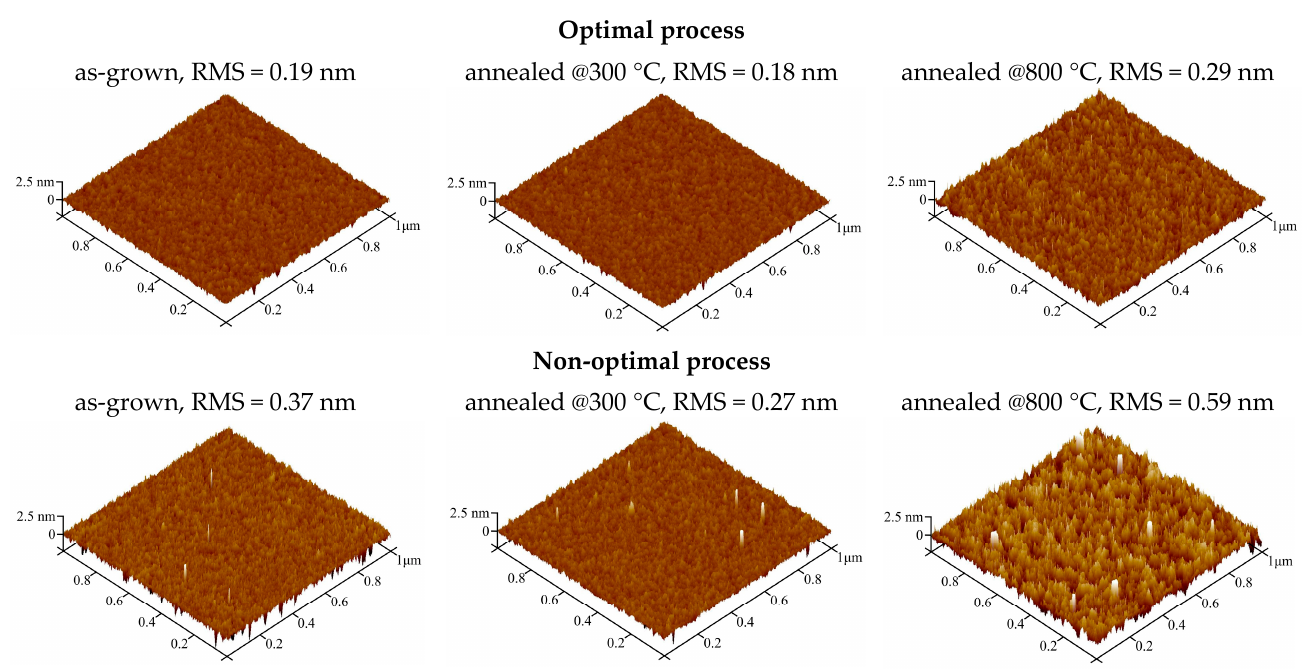
Figure 6. Morphology of HfO x N y fi lms characterized by AFM; RMS values of the investigated dielectric layers are also shown.